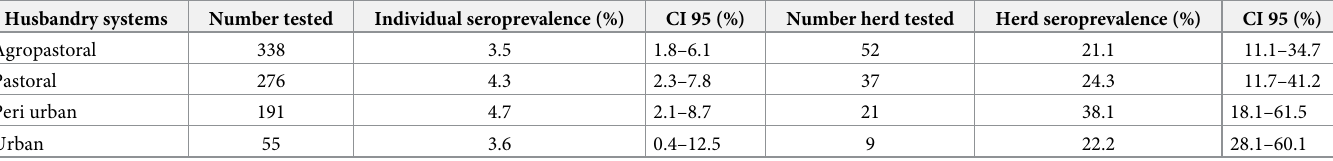
Table 3. Individual and herd seroprevalence according to husbandry systems. Data stem from study conduct in three regions of Mali. Husbandry